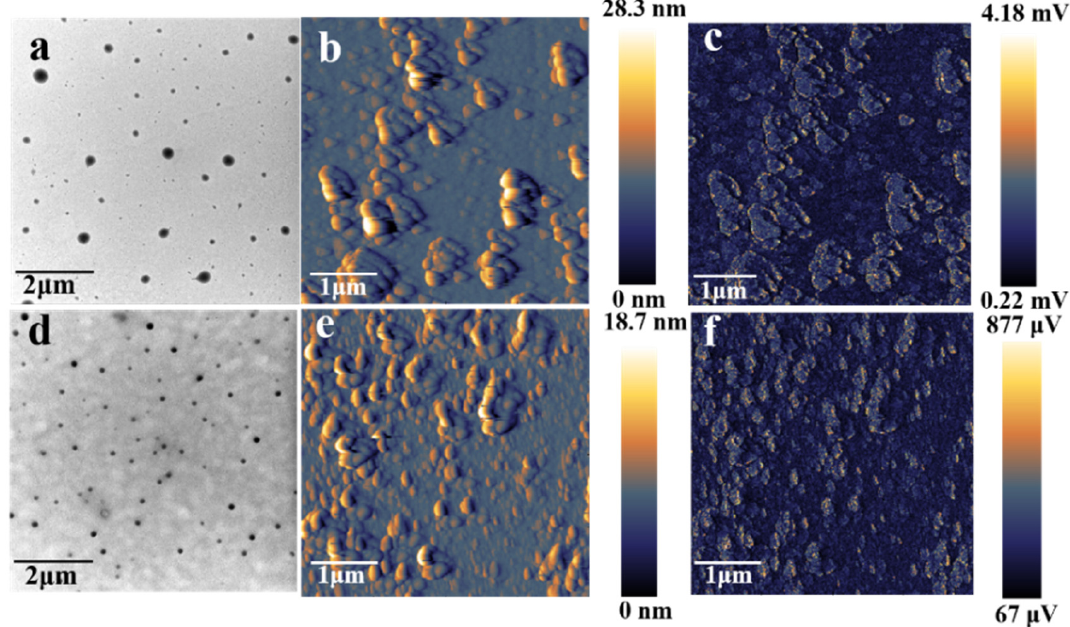
Figure 5. ( a ) TEM image of ECA-CPT-11. ( b ) Atomic force micrograph of ECA-CPT-11. ( c ) Photo- induced force micrograph of ECA-CPT-11. ( d ) TEM image of TCA-CPT-11. ( e ) Atomic force micrograph of TCA-CPT-11. ( f ) Photo-induced force micrograph of TCA-CPT-11.